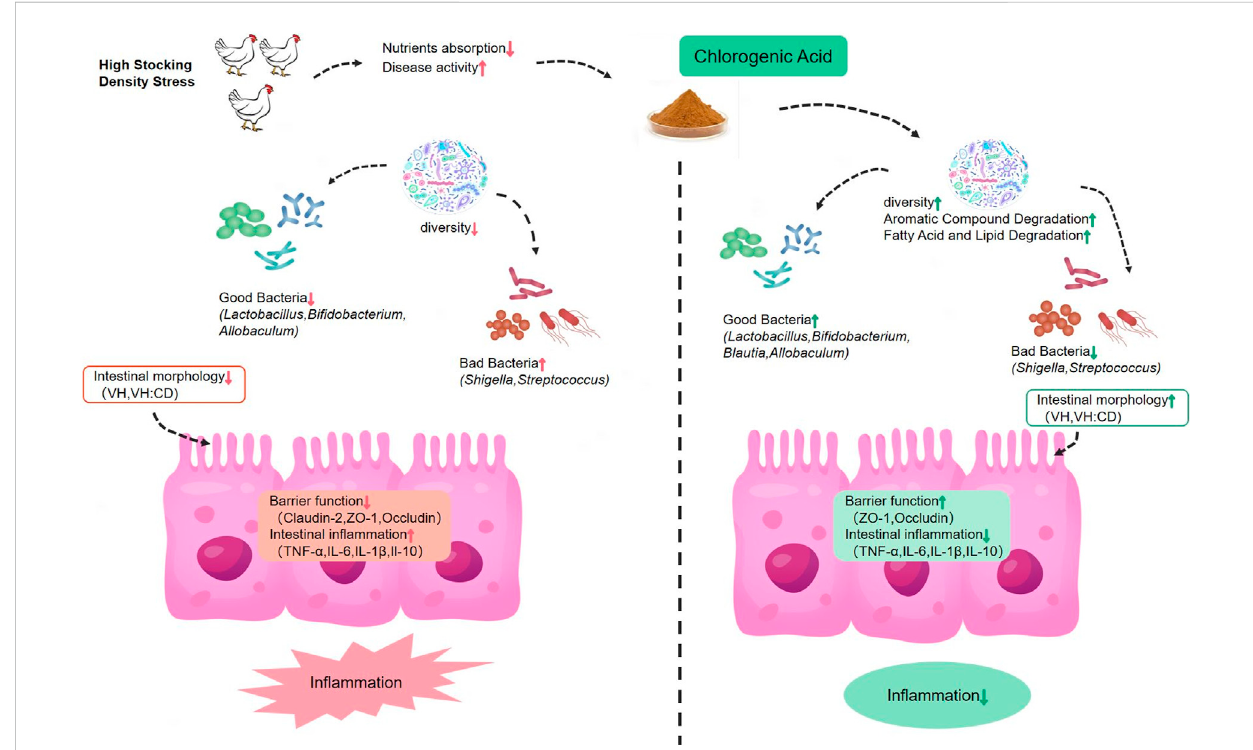
FIGURE 5 Systematic analysis of the effects of dietary chlorogenic acid on in fl ammatory index, intestinal barrier function and intestinal micro fl ora in broilers under high stocking density stress.